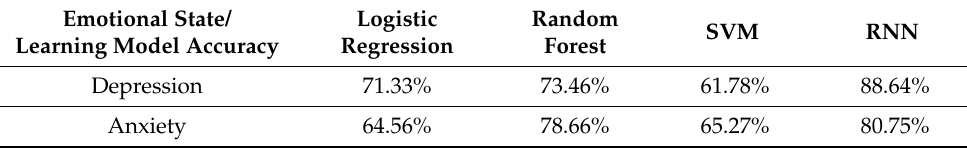
Table 2. Accuracy of Classifying Emotional States from the Probabilistic Selection Task